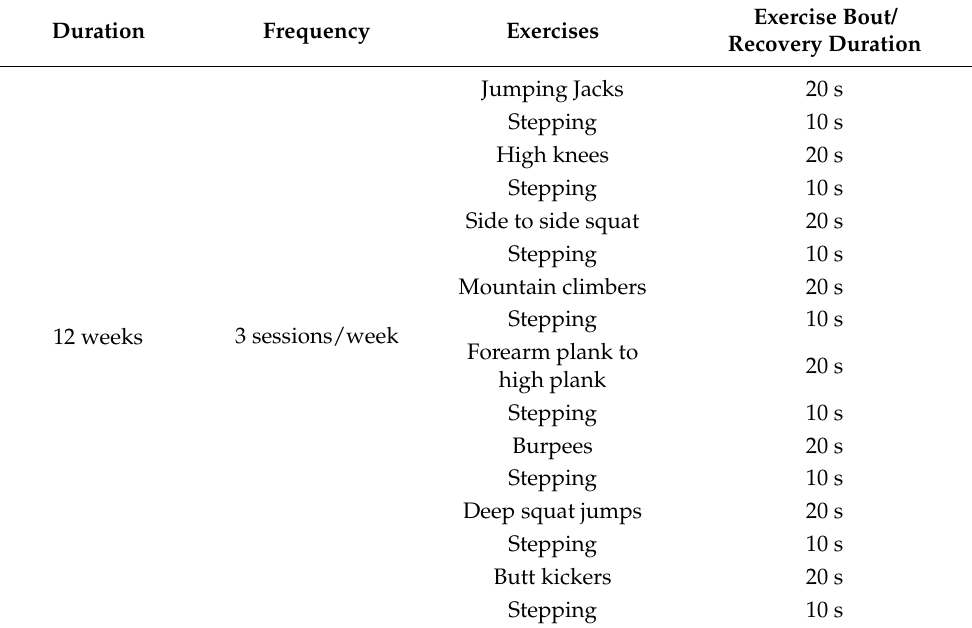
Table 2. Details of the functional high-intensity interval training